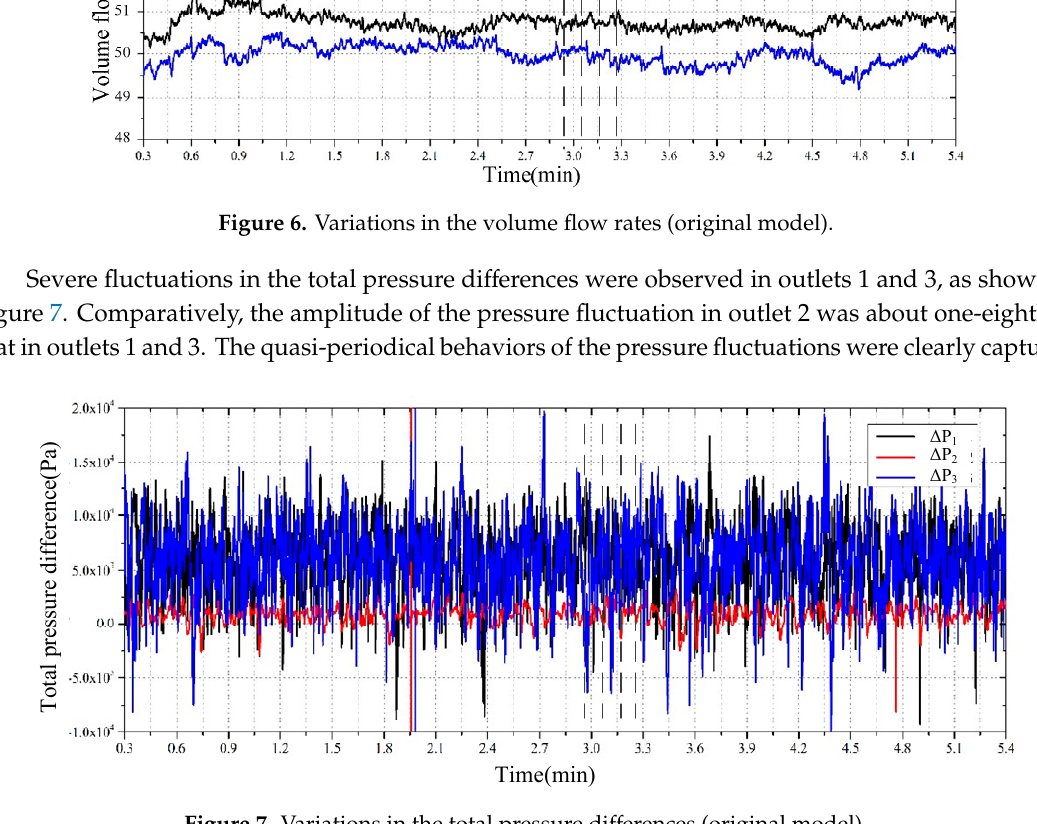
ff erences (original Figure 7. Variations in the total pressure differences (original model). Figure 7. Variations in the total pressure di Figure 7. Variations in the total pressure differences (original model).